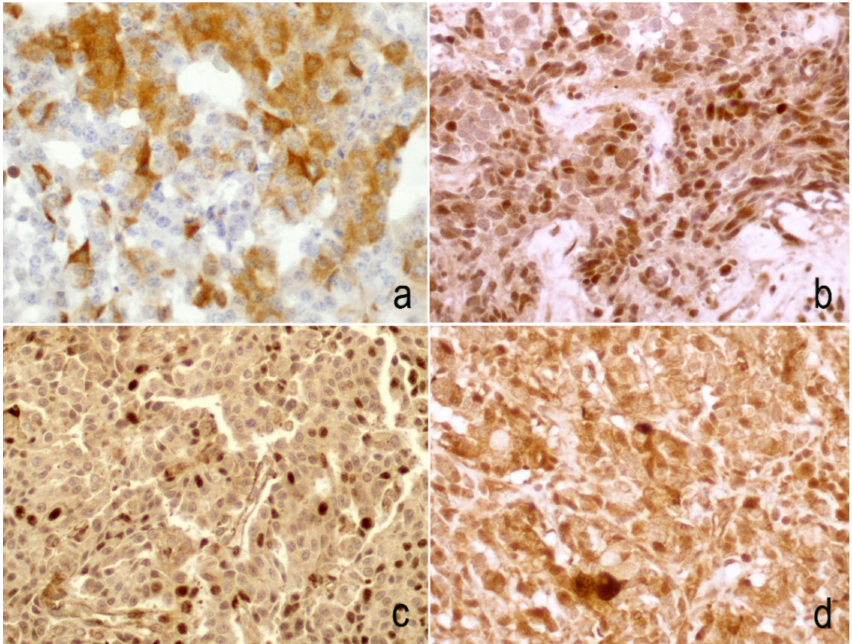
Figure 1. Examples of the Twist immunoscore—cytoplasmic signal was evident in 15–50% ( a ) and in > 50% ( d ) of neoplastic cells; in some cases an exclusive nuclear signal was observed in > 50% ( b ) and in 15–50% ( c ) of neoplastic cells. (( b – d ). 20 × magnification; ( a ). 40 × magnification).